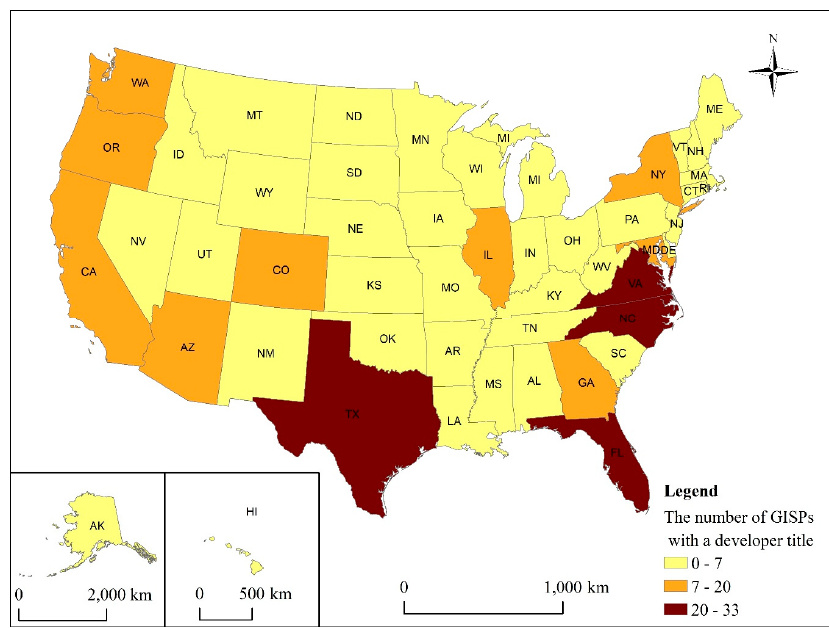
Figure 5. The map of the ratio of GISPs with an administrative role in each state.